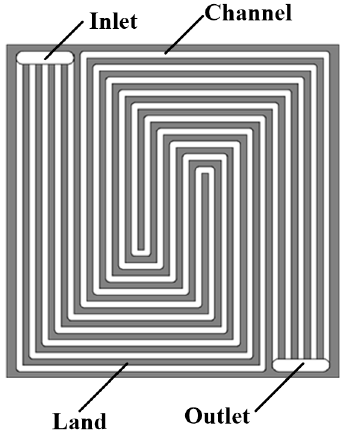
Figure 2. Flow field of the PEMFC.